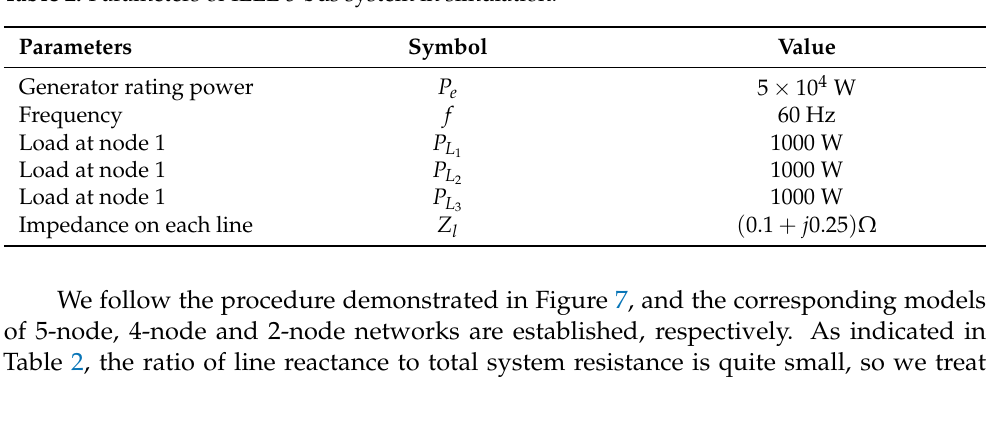
Table 2. Parameters of IEEE 5-bus system in